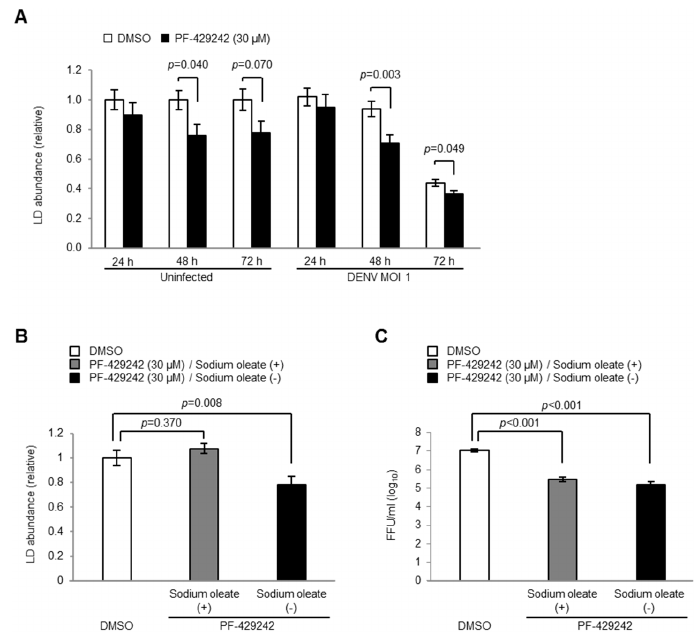
Figure 6. LD in DENV-infected cells. ( A ) Accumulation of LD at 24, 48 and 72 h p.i. in HeLa cells infected with DENV2 16681 strain at MOI 1 containing 30 µM of PF-429242 or DMSO alone ( B and C ) Accumulation of LD ( B ) and infectious viral titers in the supernatant ( C ) of DENV-infected cells at 72 h p.i. after the addition of exogenous oleic acid (20 µM). FFU: focus formation unit. Error bars indicate the SE. Means and S.E. are obtained from 3 duplicate experiments.